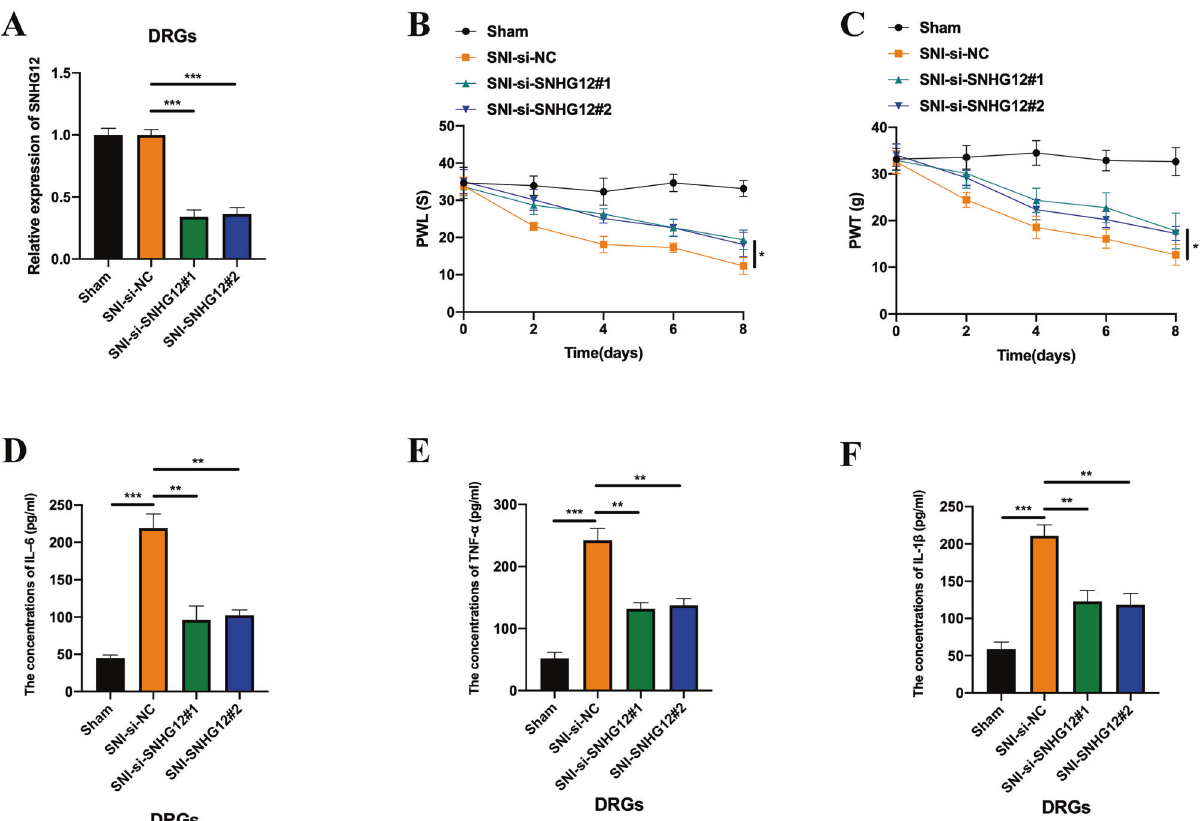
Fig. 2 LncRNA SNHG12 knockdown represses SNI induced neuropathic pain. A The relative expression level of lncRNA SNHG12 in DRGs from SNI rats pre-intrathecally injected with si-NC, si-SNHG12#1, and si-SNHG12#2. B PWL or ( C ) PWT assays were performed to assess the neuropathic pain of rats from the sham or lncRNA SNHG12 knockdown SNI groups. The levels of IL – 6 ( D ), TNF – α ( E ), and IL-1 β ( F ) in the DRGs of rats from the sham or lncRNA SNHG12 knockdown SNI groups were assessed by ELISA. Experimental data are presented as mean ± SD. * P < 0.05, ** P < 0.01, *** P <